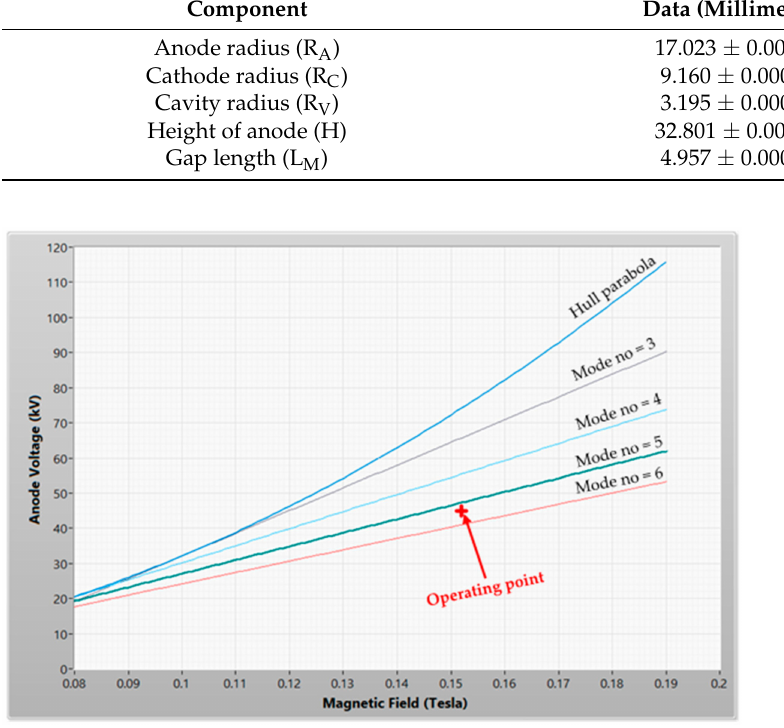
Figure 14. The results of calculation of a suitable voltage for the operating